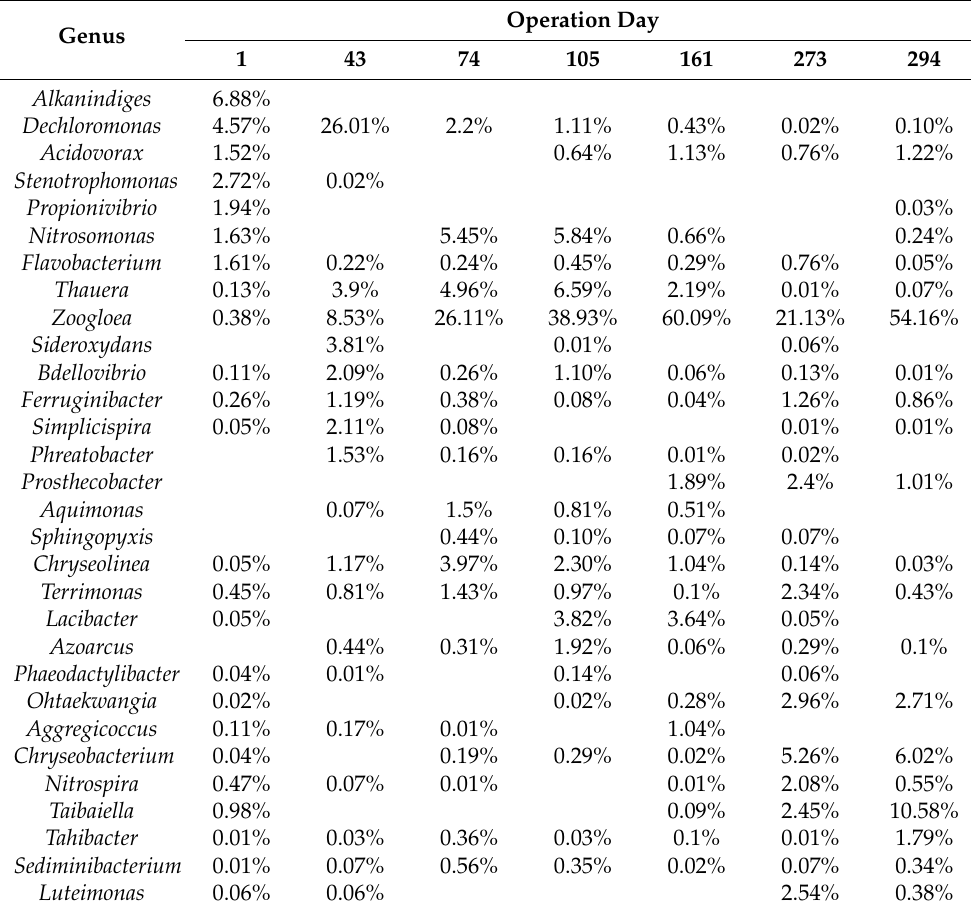
Table 2. Predominant microbial genera in